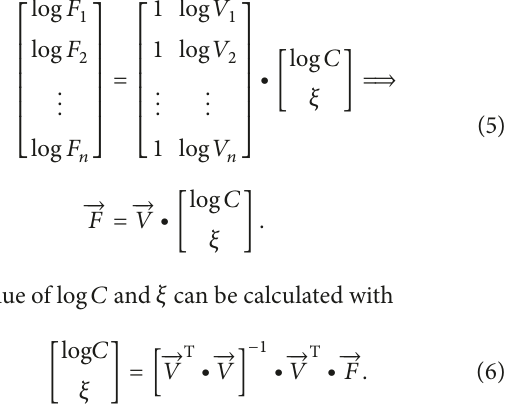
log 𝐶 and 𝜉 . To solve the least squares problem, the normal equations method can be